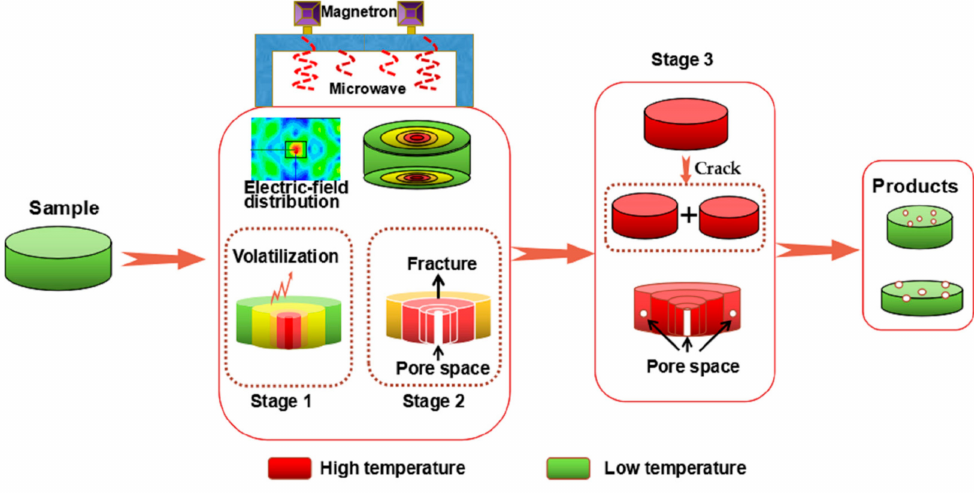
Figure 11. Schematic diagram of the microwave heating process of the NCS.